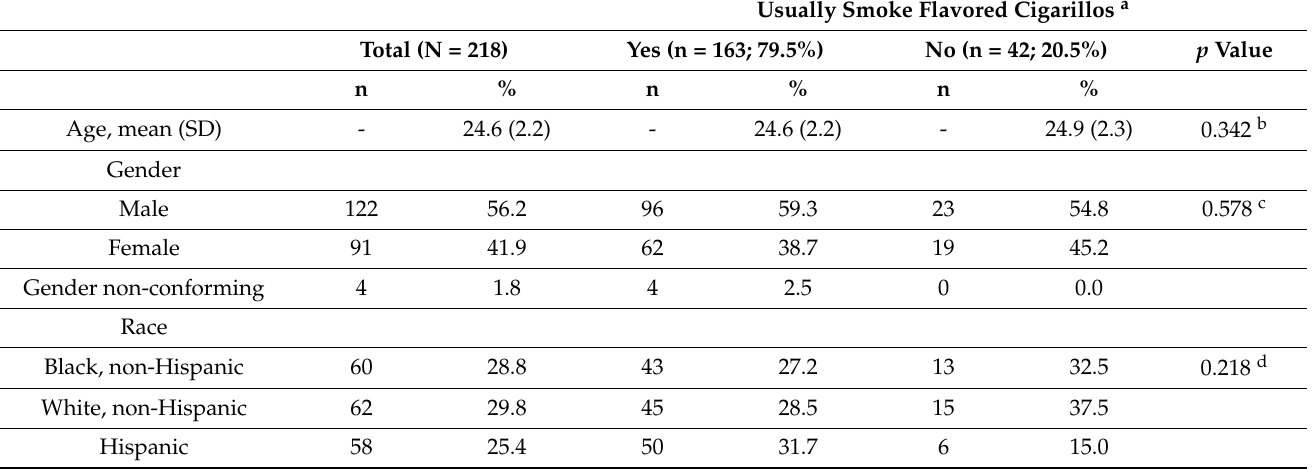
Table 1. Demographics and Other Characteristics of C-FLASH Young Adults Who Used Cigarillos and Cannabis in the Past 30 Days (N = 218).